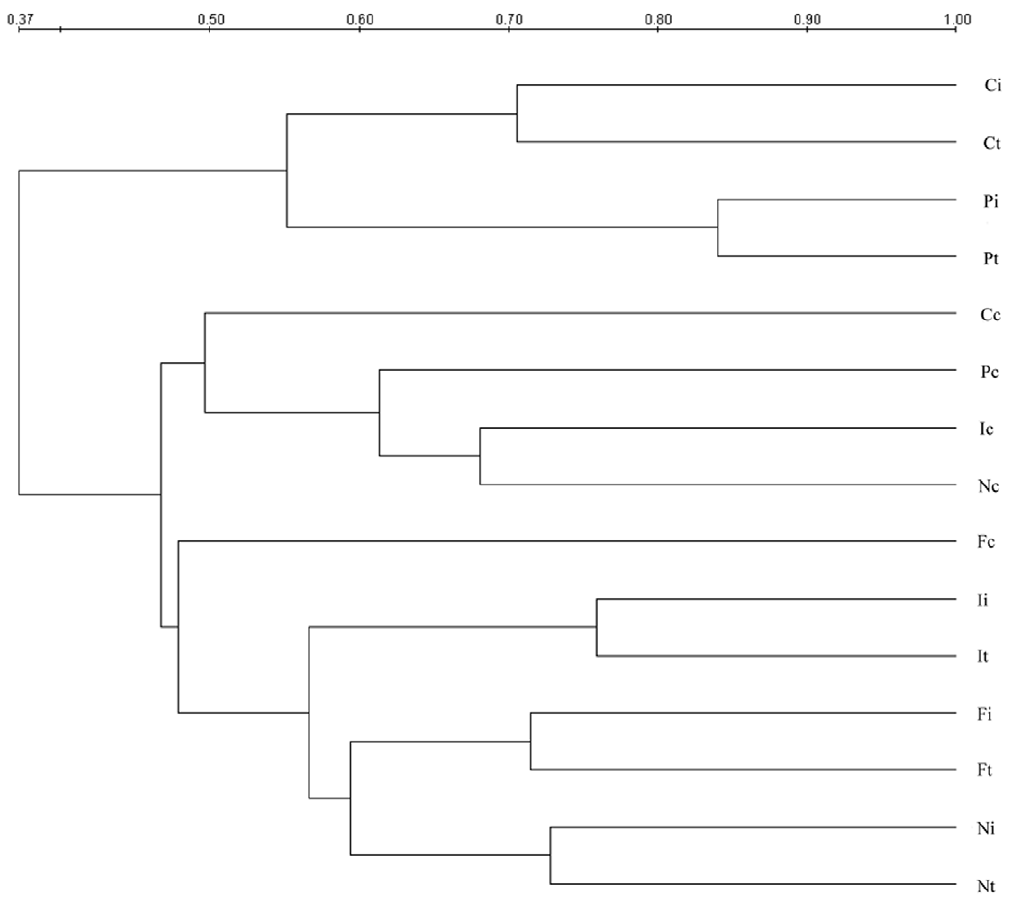
Figure 2. Dendrogram derived from DGGE analysis based on UPGMA clustering algorithm. The scale shown here represents percentage similarity between DGGE profiles.